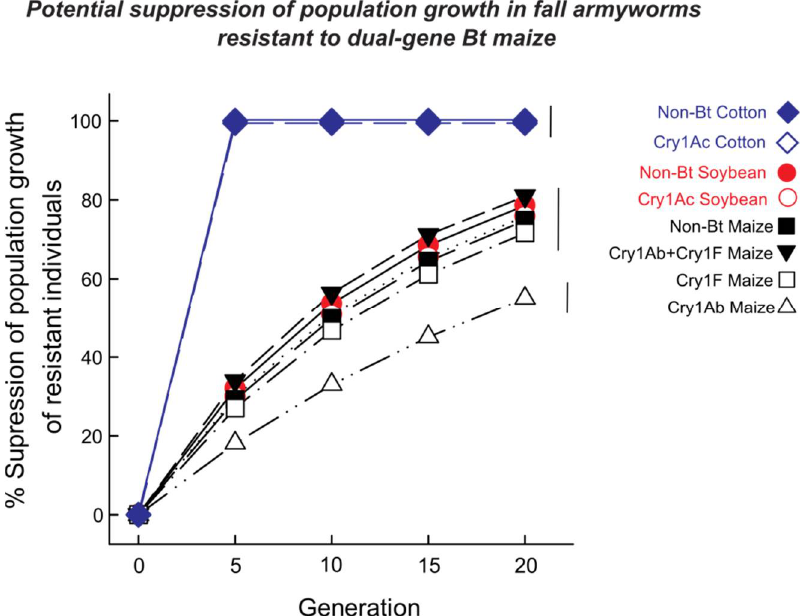
Figure 6. Potential suppression of population growth of a Cry1A.105+Cry2Ab2-resistant population of the fall armyworm ( Spodoptera frugiperda ) in the foliage of eight host-plant cultivars due to fitness costs of the resistance. The population size (Nt) for the Bt-resistant and Bt-susceptible population was estimated using the exponential growth model for each cultivar; at generation t , the population size value of the Bt-resistant population was divided by the population size value of the Bt-susceptible population (see Section 2).